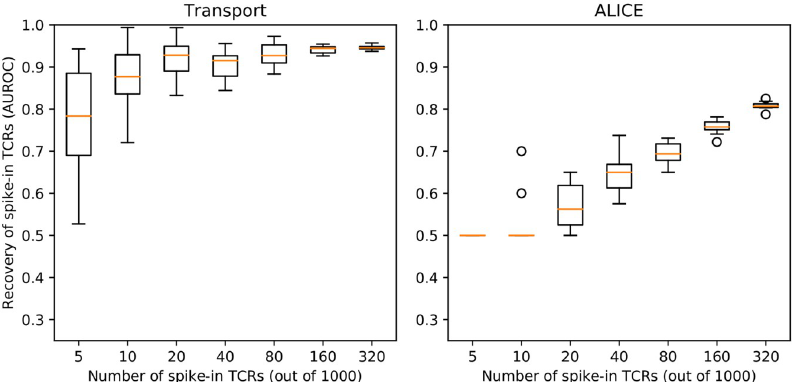
Fig 9. Recovery of “spike-in” epitope-specific TCRs from background naive TCRs based on optimal transport (left) or the ALICE algorithm (right). The bars summarize AUROC values for 10 random